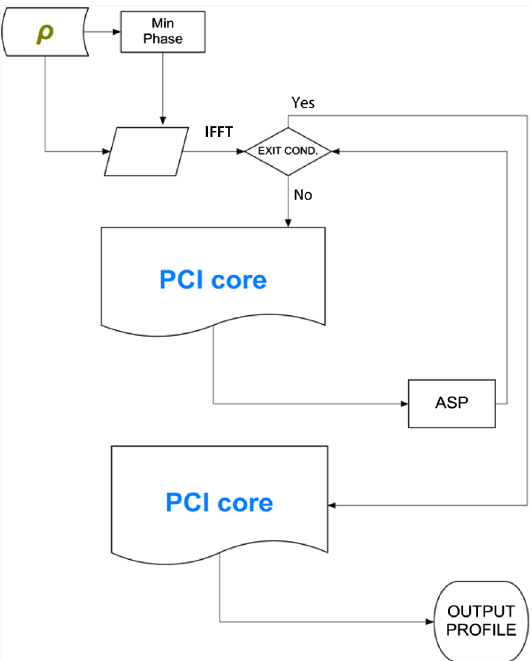
FIG. 1. Schematic diagram of PCI algorithm with exit conditions defined by Eqs. (3) and